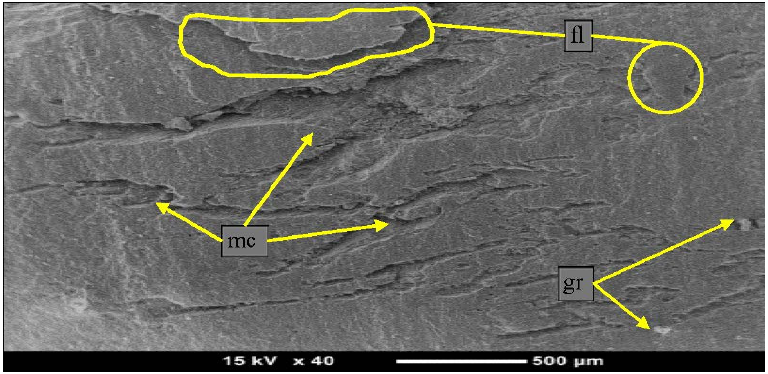
Figure 8. Micrographs of neat epoxy after adhesive testing. (fg: fragmentation; so: softening; Cr: cracks)